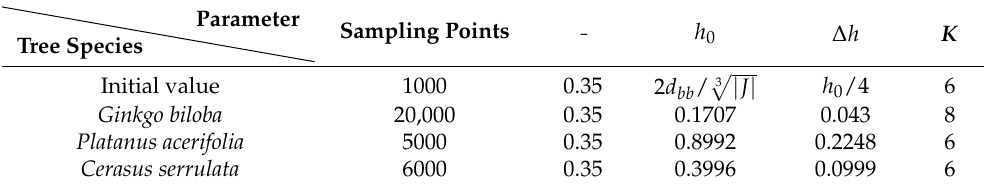
Table 2. The initial parameter setting of three individual tree initial skeleton point